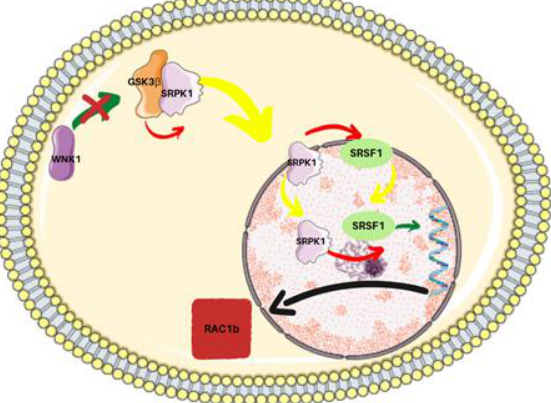
Figure 5. Mechanism of alternative splicing of RAC1b inhibition by ibuprofen. The red color of the arrow means phosphorylation, yellow translocation, and green binding. The symbol “x” indicates the site of action of ibuprofen. Lysine deficient protein kinase 1 (WNK 1), Glycogen synthase kinase 3 beta (GSK3 β ), Serine/arginine-protein kinase (SRPK 1), Serine/arginine-rich splicing factor 1 (SRSF 1), Ras-related C3 botulinum toxin substrate 1B (RAC1b)